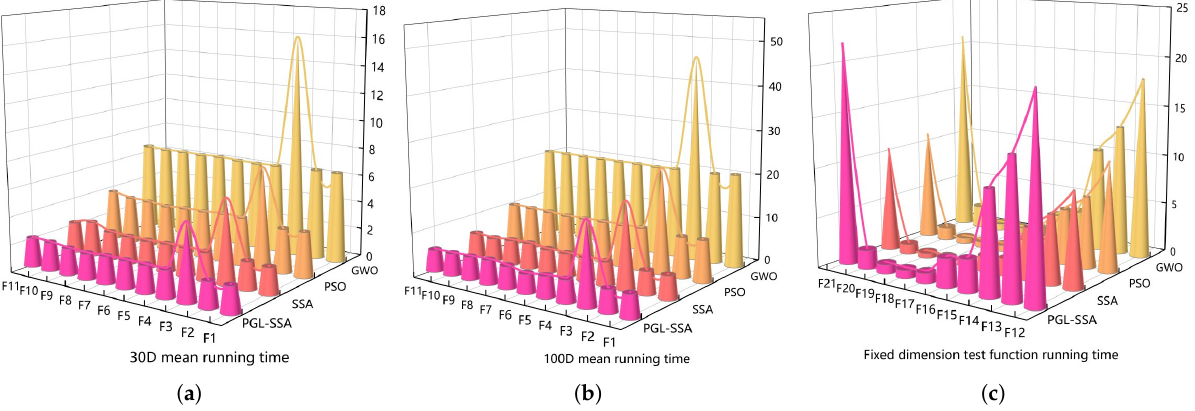
Figure 8. Comparison of running time of different algorithms in each dimension. ( a ) 30D mean running time, ( b ) 100D mean running time, ( c ) Fixed dimension test function running